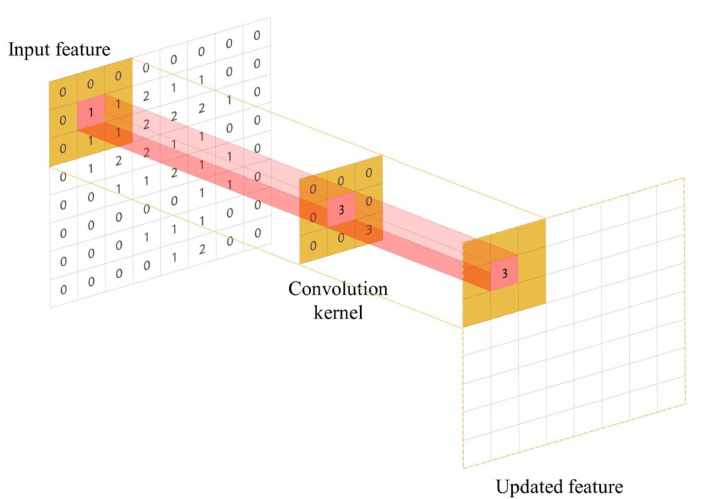
Figure 1. Illustration of convolutional neural